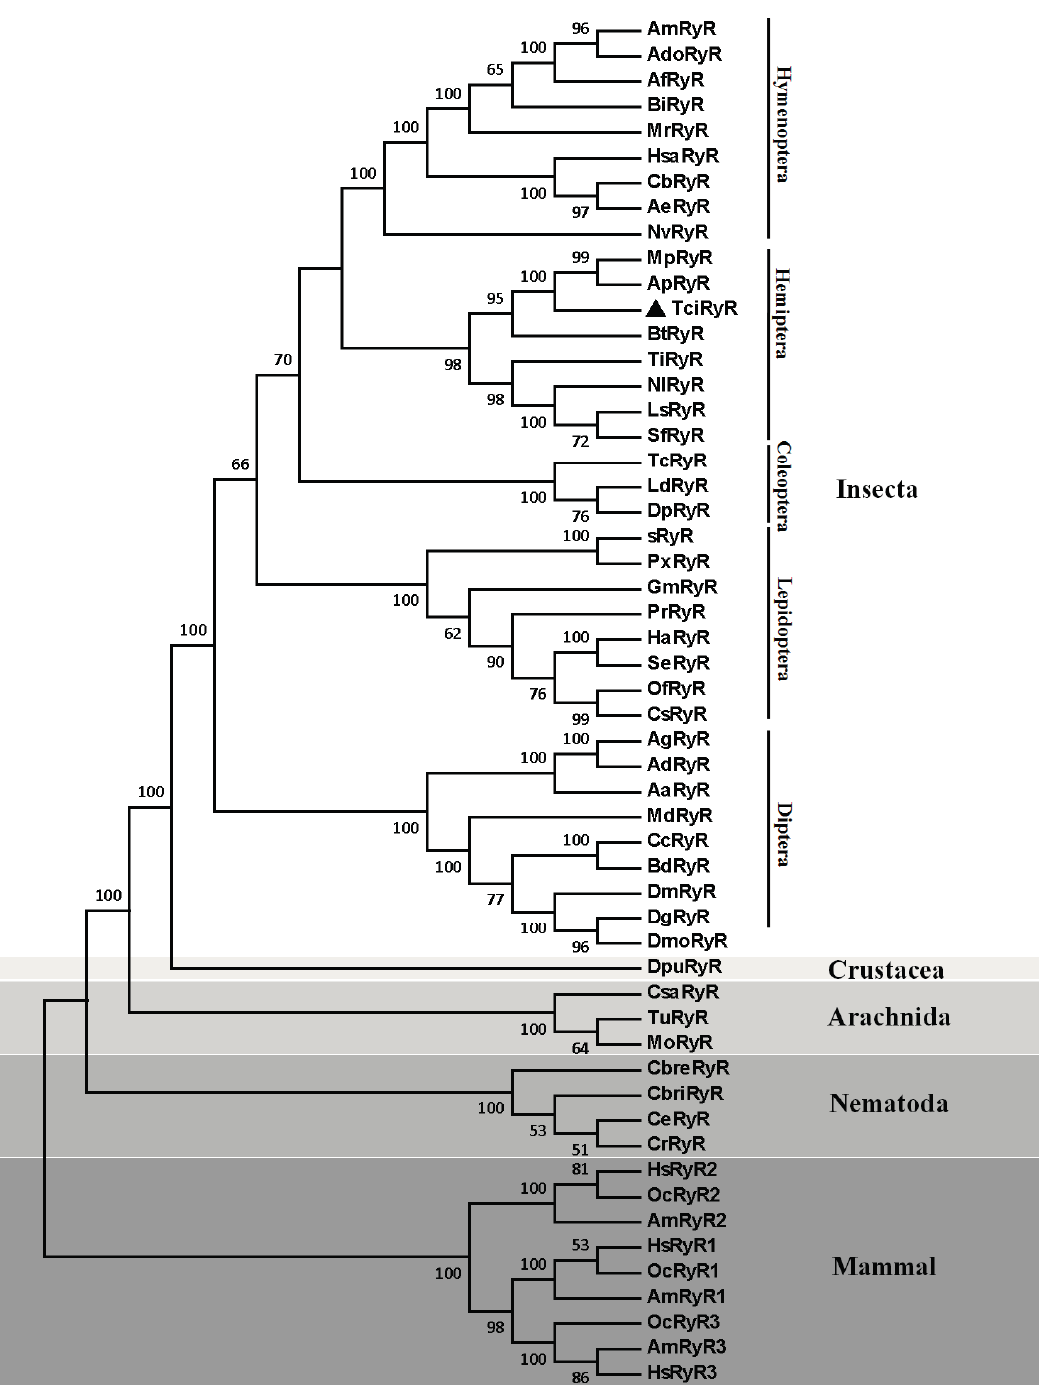
Figure 2. Phylogenetic tree of the ryanodine receptor (RyR) family. The TciRyR amino acid sequences were aligned to 53 representative RyR homologs from 47 species and used for phylogenetic analysis. Only bootstrap values exceeding 50% were shown at branch points. GenBank accession numbers of all sequences are listed in the Table